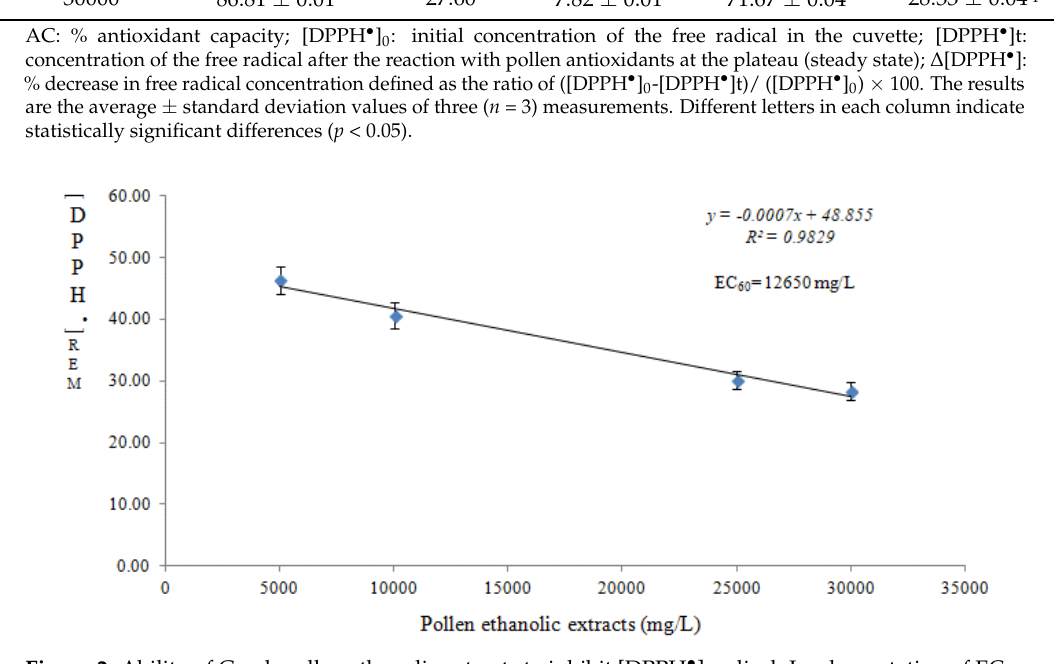
Figure 2. Ability of Greek pollen ethanolic extracts to inhibit [DPPH • ] radical. Implementation of EC 60 . Error bars are provided at the confidence level of p < 0.05. Table 2. Antioxidant capacity (%AC) and total phenolic content (TPC) of bee pollen ethanolic extracts.